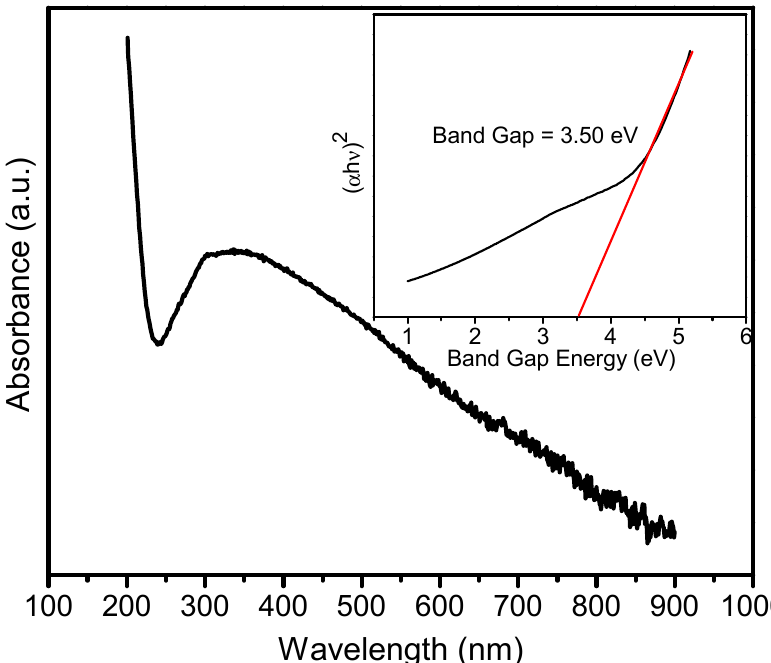
Figure 5. UV–Vis absorption spectrum of ZnWO 4 -NPs@rGO nanocomposites. Inset shows the band gap energy of ZnWO 4 -NPs@rGO nanocomposites.